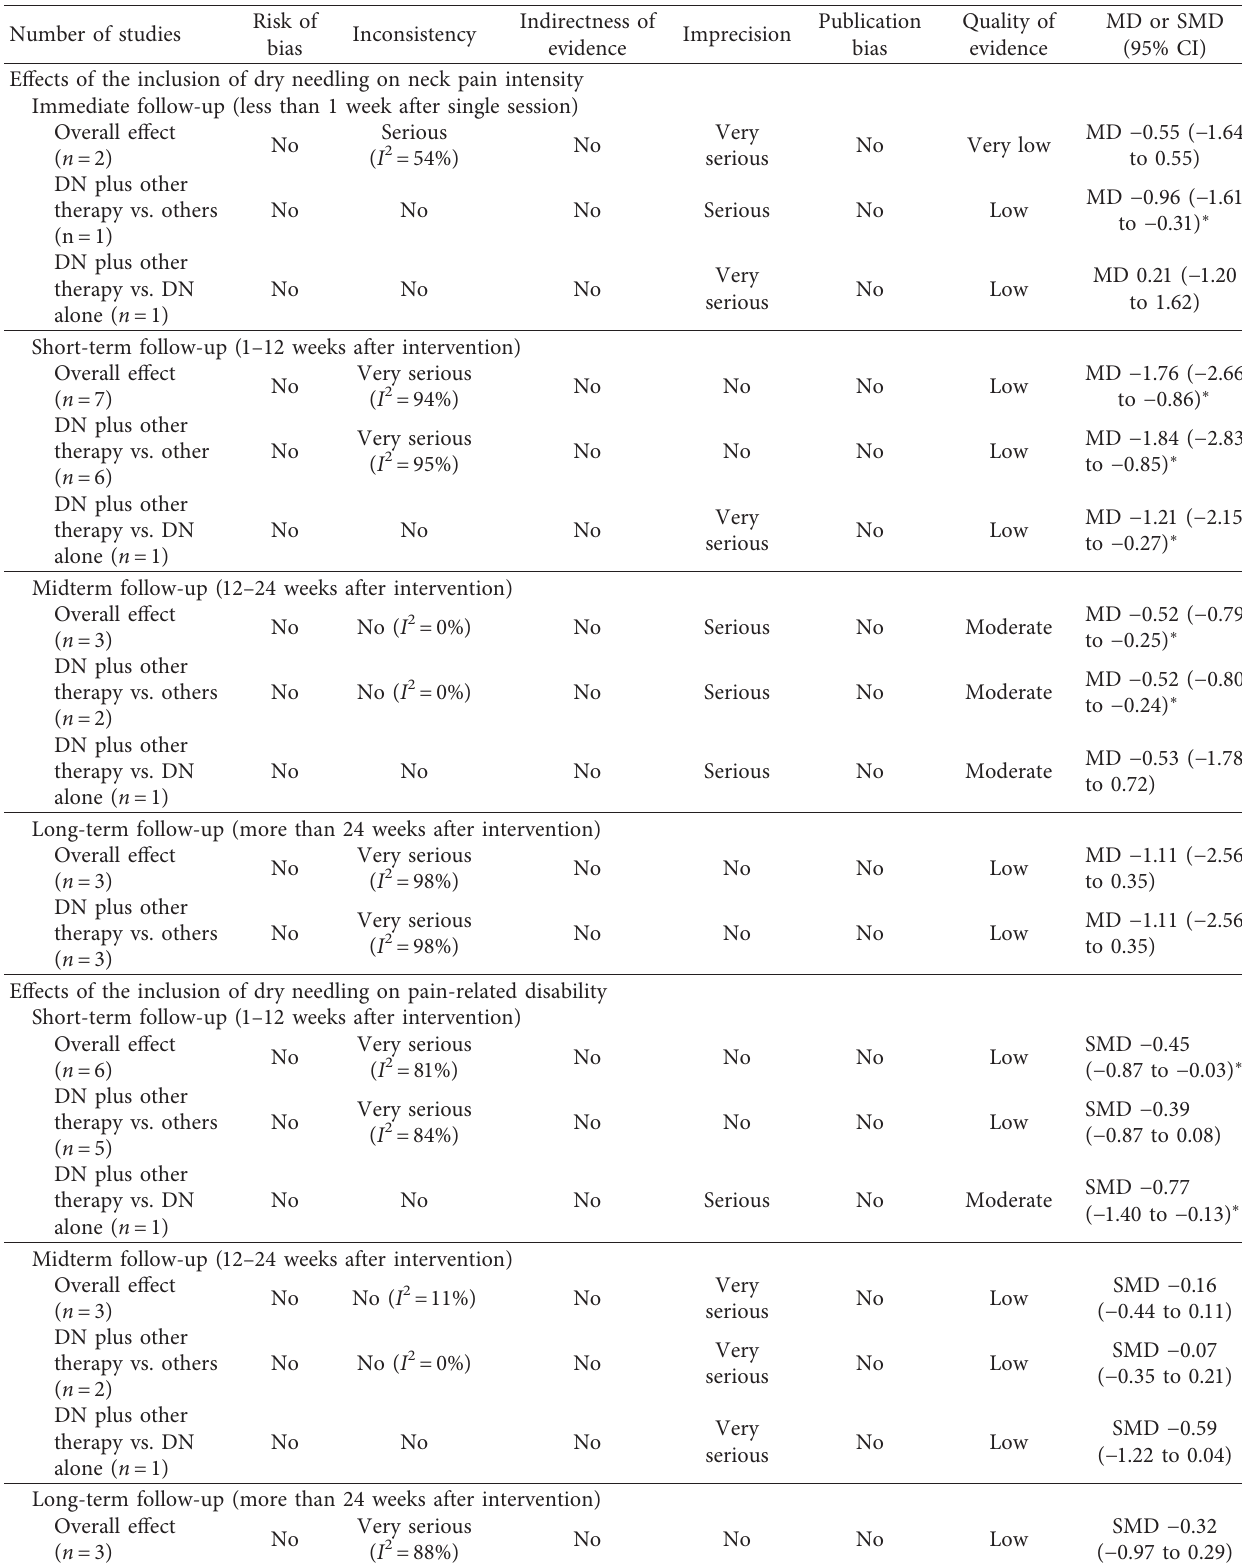
Table 4: Level of evidence (GRADE) for dry needling on pain intensity, pressure pain sensitivity, and cervical range of motion in patients with neck